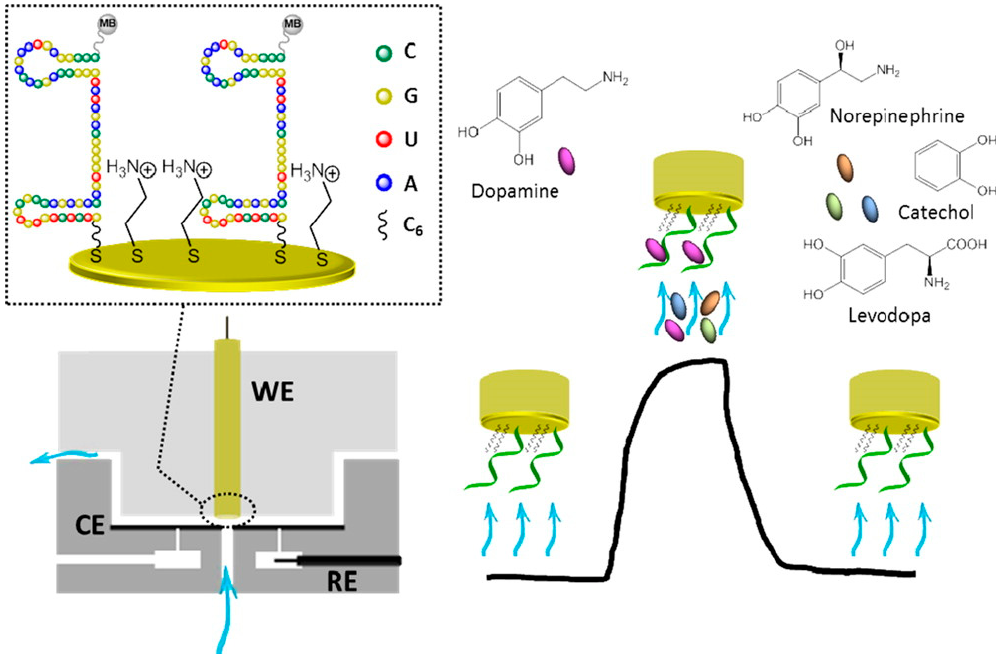
Figure 5. Schematic representation (left panel) of the flow-through wall-jet electrochemical cell (with a working electrode (WE), a counter electrode (CE), and an Ag/AgCl (0.1 M KCl) reference electrode (RE)) used for dopamine electroanalysis and the aptamer-modified gold electrode surface. The right panel image shows the chronoamperometric response of the aptasensor to dopamine, selectively trapped from the flow of neurotransmitterss over the sensor surface. Following each measurement, the electrode surface was regenerated in a flow of a blank buffer solution to remove the oxidized analytes [58]. Copyright 2016, American Chemical Society.